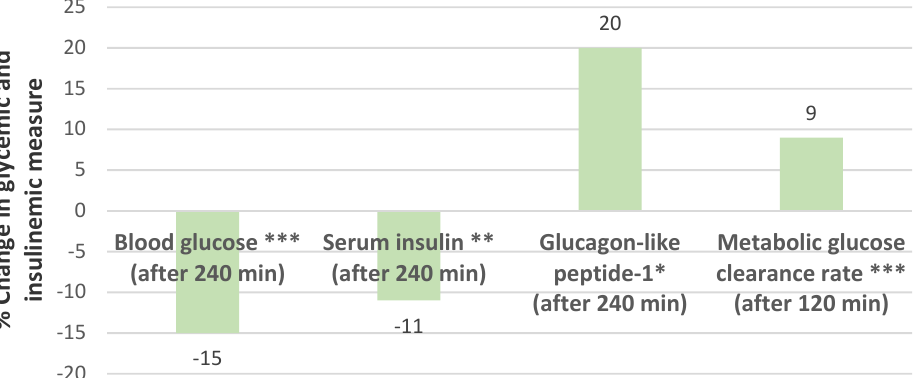
Figure 32. Postprandial % change in area under the curve (AUC) for blood glucose and insulin responses for isocaloric white bread plus almonds vs. white bread plus butter and cheddar cheese meals (* p = 0.283, ** p = 0.021, **** p ≤ 0.005) [90].